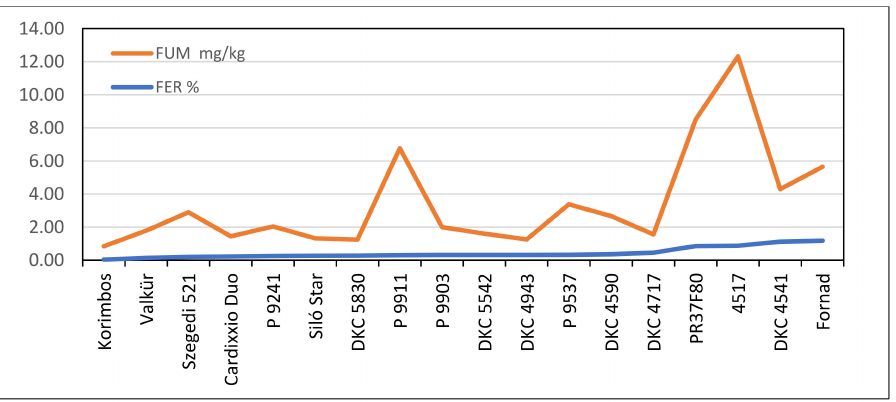
Figure 2. F. verticillioides kernel ear rot and fumonisin B 1 +B 2 contamination in 2017–2018. The LSD 5% value for FB 1 +FB 2 is 4.00. The distance between fumonisin’s corresponding point on the regression line and the actual FUM B 1 +B 2 contamination for the P9911 and 4517 hybrids are 4.15 and 6.23, and they are larger than the LSD 5% value of 4.0. The fumonisin overproduction of these two hybrids is proven. Variances for the toxins can be found for each data point in Table